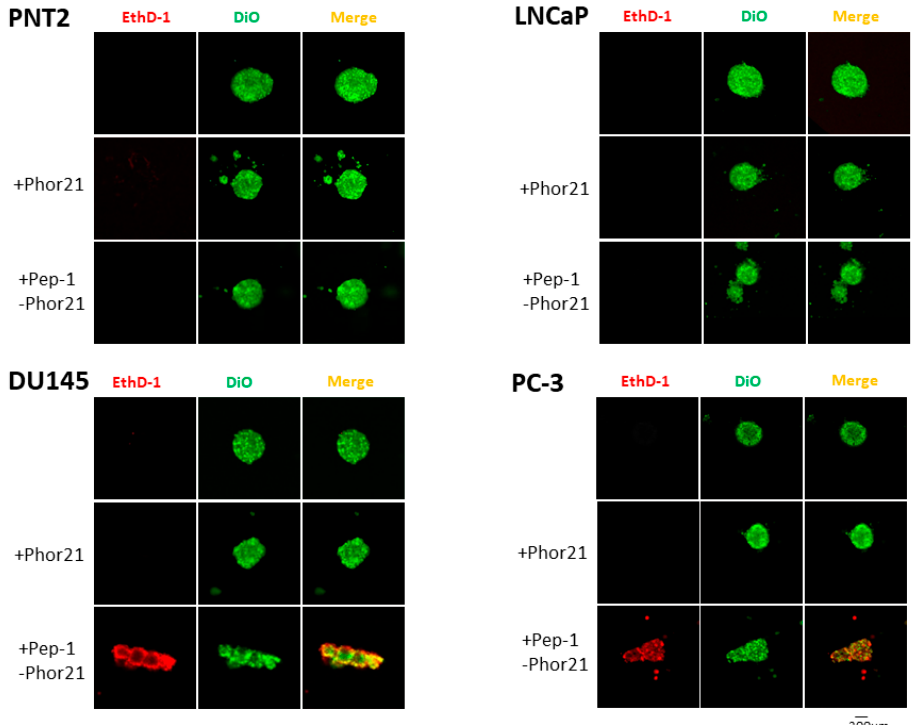
Figure 9. Effect of Pep-1-Phor21 on 3D-cultured prostate cancer cells assessed via live/dead staining. The prostate cancer cells were treated without or with 30 µM of Phor21 or Pep-1-Phor21 for 3 h and the viability of cells was assessed via staining for live (fluorescent vital membrane dye Vybrant DiO, green) and dead (ethidium homodimer I (Ethd-1), red) cells.